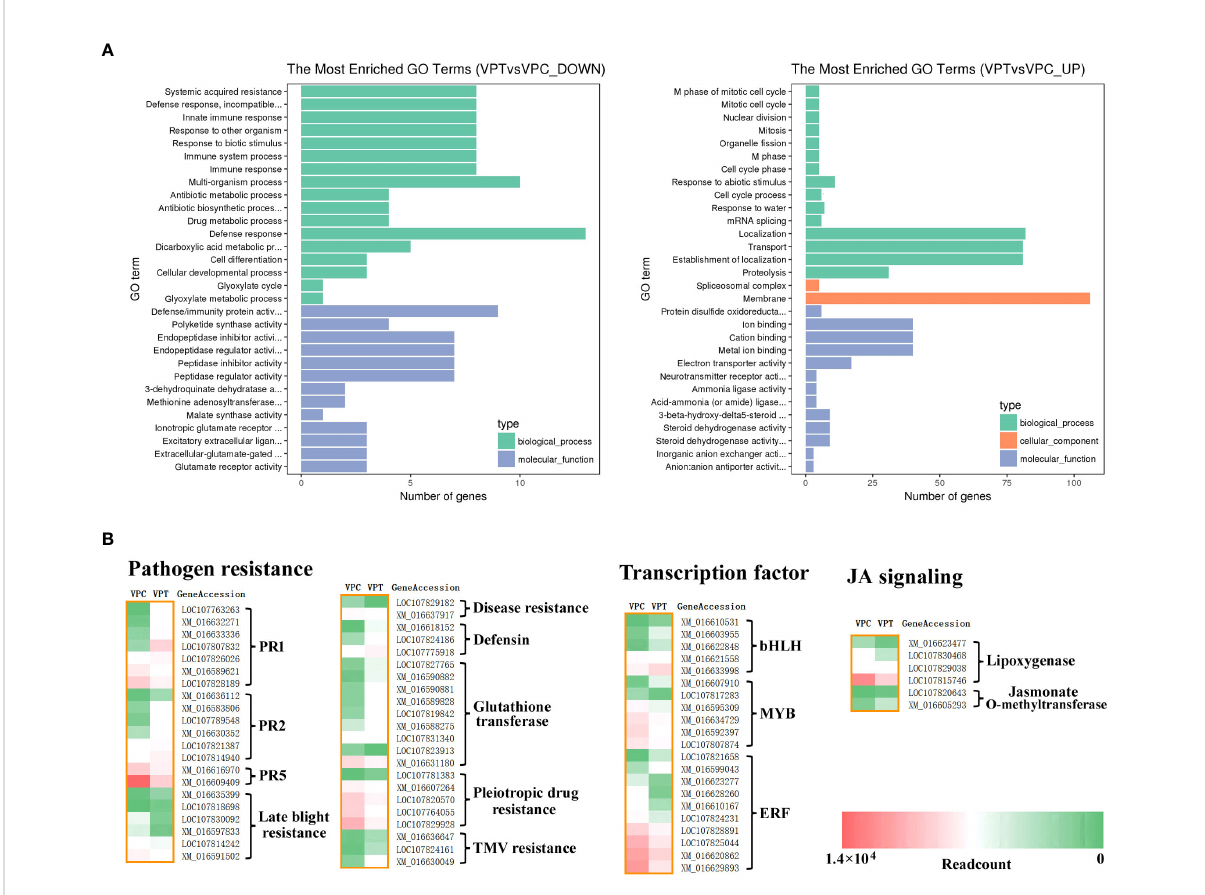
FIGURE 2 Analysis of DEGs between control and NtCOI1 -RI plants. (A) The enrichment of down-regulated (left) and up-regulated (right) DEGs in NtCOI1 - RI plants compared with control by GO terms. (B) Diagrammatic pro fi le of the differentially expressed pathogen resistance gens, transcription factor genes, and JA-signaling genes in control and NtCOI1 -RI plants. Color-bar at bottom-right corner indicates the number of readcounts. VPT indicates NtCOI1 -RI plants and VPC indicates control